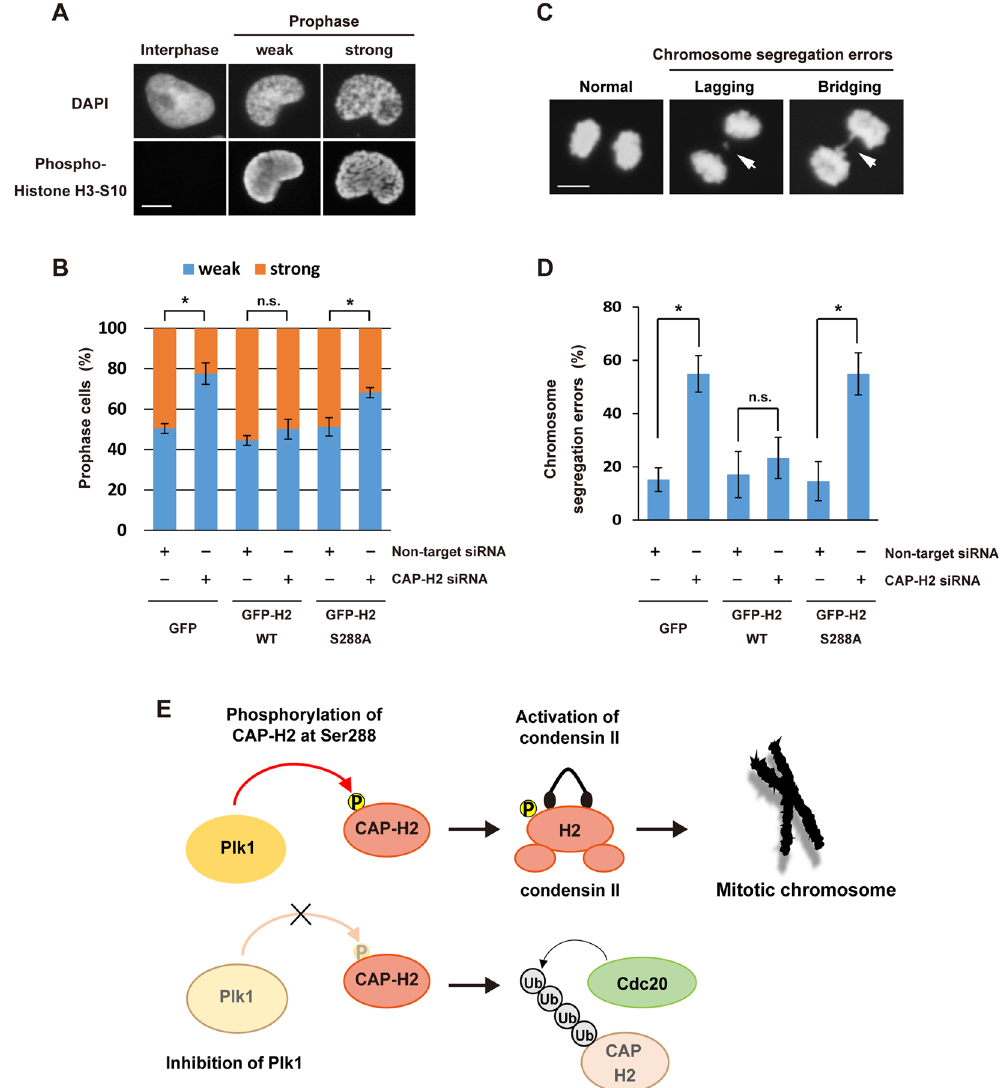
Figure 6. S288 phosphorylation is required for the condensin II functions during mitosis. ( A ) GFP, GFP- CAP-H2-WT or GFP-CAP-H2-S288A stable cell lines were transfected with non-target siRNA or CAP-H2 siRNA. The cells were fixed and stained with anti-phospho-histone H3-Ser10. DNA was stained by DAPI. Degrees of prophase chromosome condensation were defined in the two categories and the representative cells are shown. Scale bar, 10 μ m. ( B ) GFP, GFP-CAP-H2-WT, or GFP-CAP-H2-S288A stable cell lines were transfected with non-target siRNA or CAP-H2 siRNA and then fixed. The percentage of each category, defined in A, was calculated. n > 100 cells per indicated condition were analyzed. Data represent mean ± SD from three independent experiments. Statistical analysis was performed with the Student’s t test ( * P < 0.05). ( C ) GFP, GFP-CAP-H2-WT, or GFP-CAP-H2-S288A stable cell lines were transfected with non-target siRNA or CAP- H2 siRNA. The cells were fixed and stained with anti-phospho-histone H3-Ser10. DNA was stained by DAPI. The anaphase cells were assessed for the presence of chromosome segregation errors, lagging and/or bridging chromosomes. The representative cells are shown. Scale bar, 10 μ m. ( D ) The percentage of chromosome segregation errors, as described in C, was calculated. n > 100 cells per indicated condition were analyzed. Data represent mean ± SD from three independent experiments. Statistical analysis was performed with the Student’s t test ( * P < 0.05). ( E ) A model of condensin II regulation by Plk1 kinase. Plk1 phosphorylates CAP- H2 at Ser288 in mitosis. Ser288 phosphorylation is concerned with the fluctuation of CAP-H2 and regulates condensin II functions during